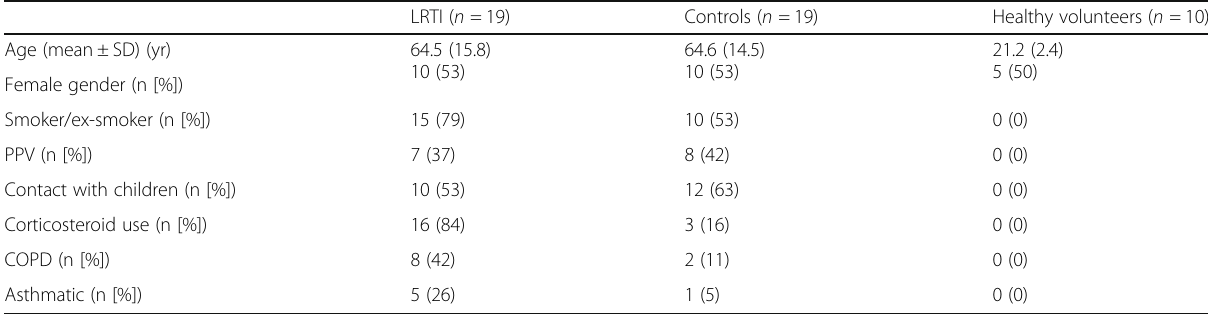
Table 1 Study population